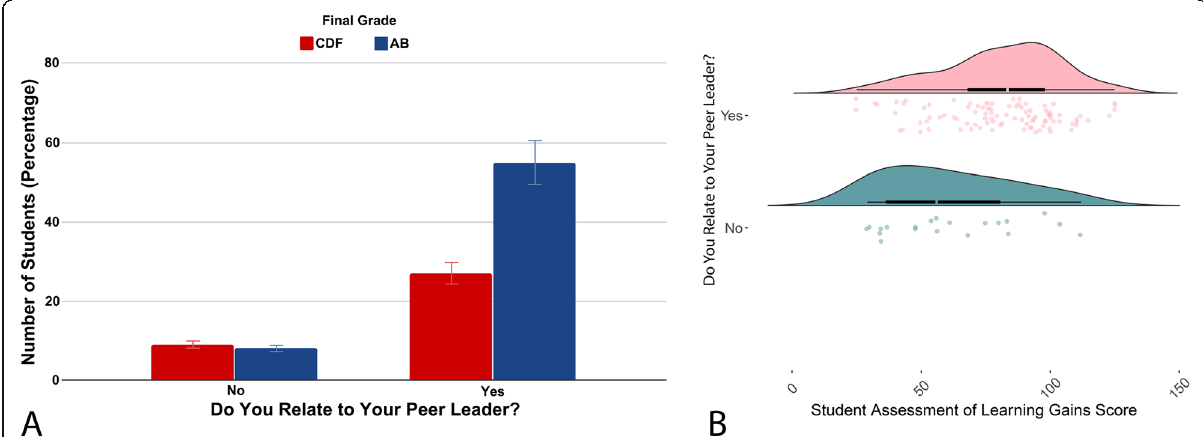
Fig. 1 Impact of Peer Leader Relatability on Student Learning Outcomes. Panel a BIO 121 students enrolled in Peer Led Team Learning who indicated they related to their peer leader finished the Introductory Biology course with significantly higher course grades than students who did not relate to their peer leader ( p = .045). Panel b Students who related to their peer leader also reported significantly higher self-assessed learning gains than their fellow classmates who did not relate to their peer leaders (dots are jittered for readability)